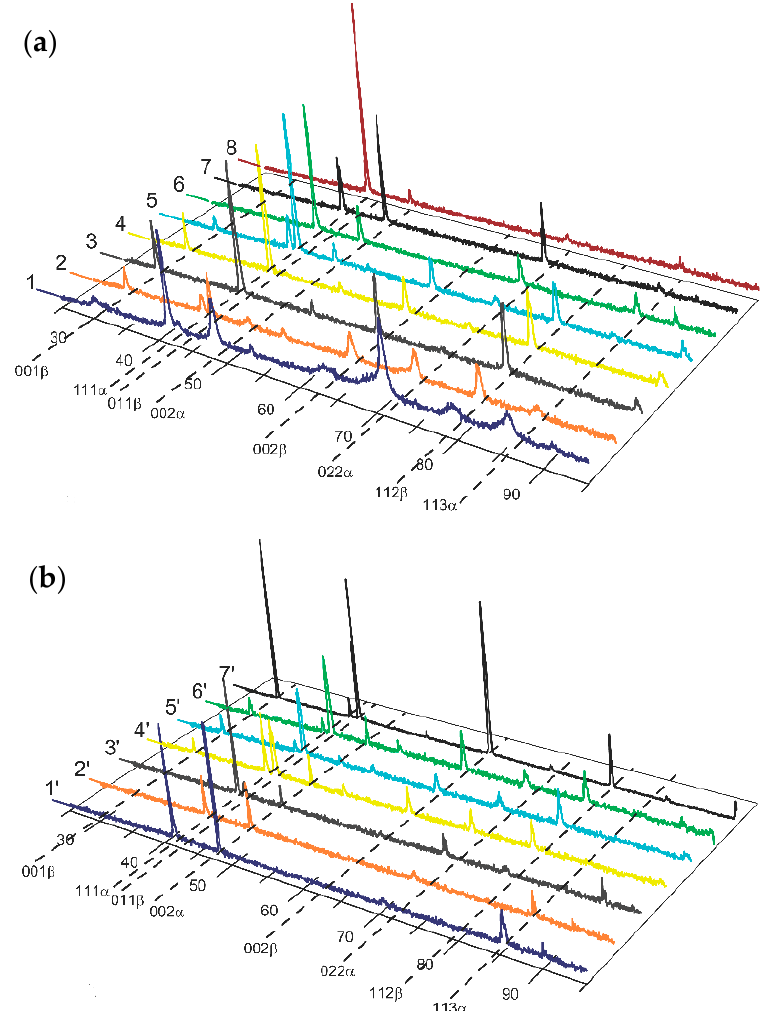
Figure 1. Variation of the X-ray diffraction patterns of the Cu-Pd36 sample during: ( a ) heating up to 25 (1), 200 (2), 300 (3), 400 (4), 500 (5), 600 (6), 700 (7), and 800 ° С (8); ( b ) cooling down to 700 (1 ′ ), 600 (2 ′ ), 500 (3 ′ ), 400 (4 ′ ), 300 (5 ′ ), 200 (6 ′ ), and 25 ° С (7 ′ ).